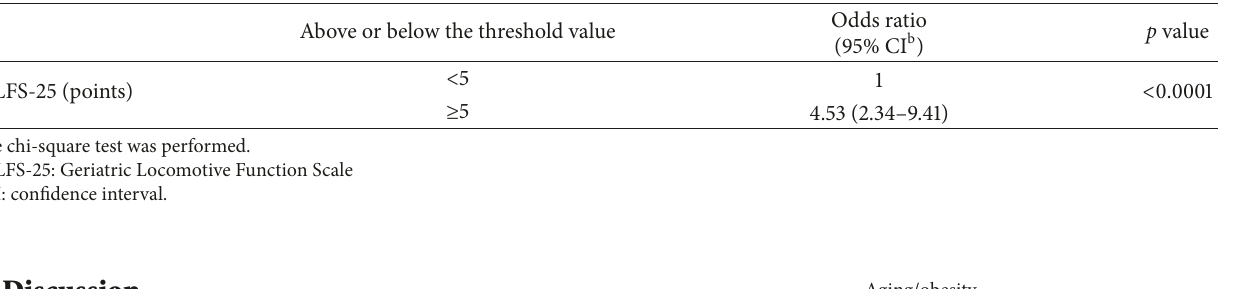
Table 5: Evaluation of odds ratio for depression according to GLFS-25 a score.